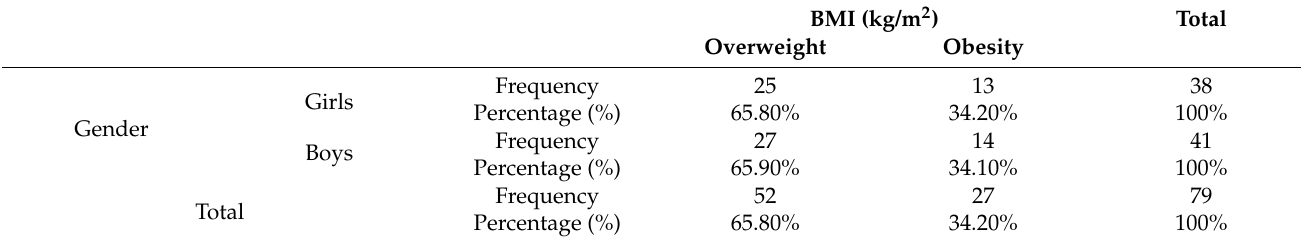
Table 4. Distribution of initial body mass indices by